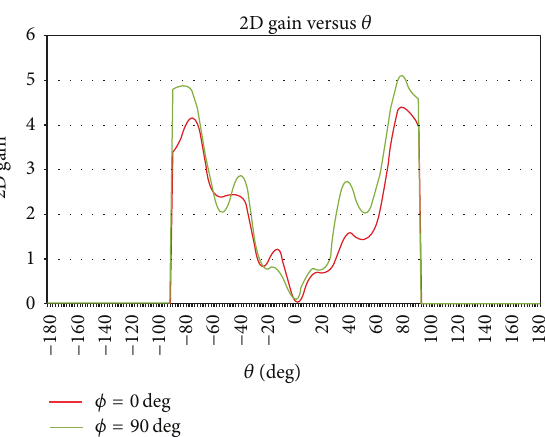
Figure 16: 2D gain of the CRA for the second iteration at 6.55 GHz.